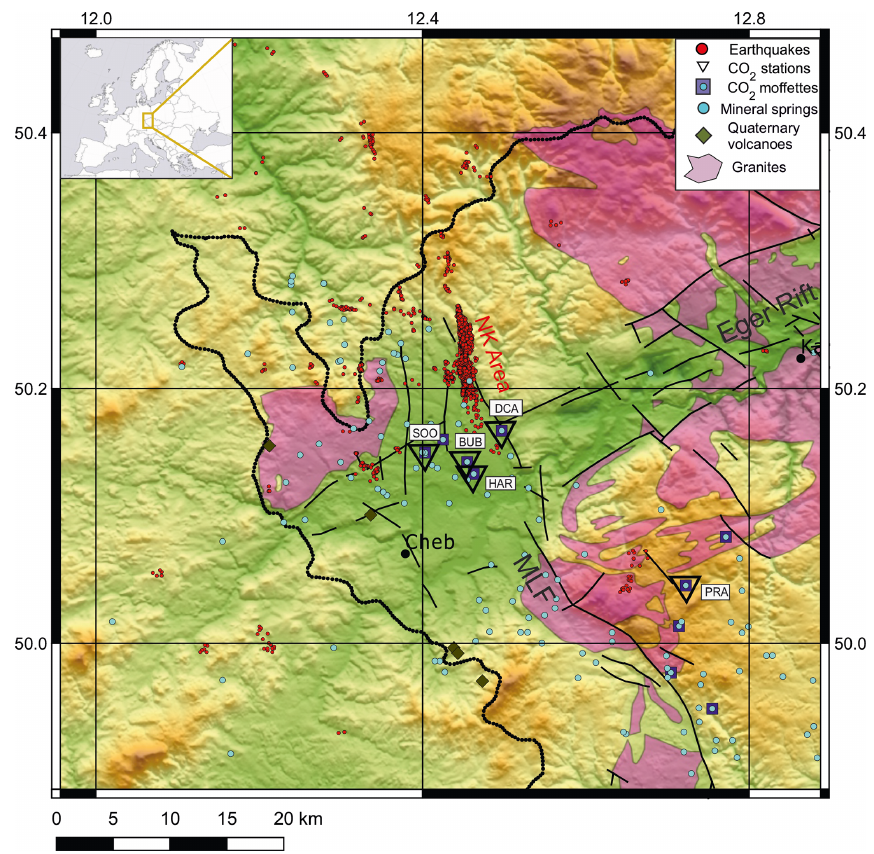
Figure 1. Relief map of the West Bohemia/Vogtland region with the fault network, granite units, and major fault zones as Mariánské Láznˇe Fault (MLF) and Eger Rift. Seismic events, the major focal zone of Nový Kostel (NK area), CO 2 monitoring stations, CO 2 mofettes and mineral springs, and Quaternary volcanoes are also indicated (see the